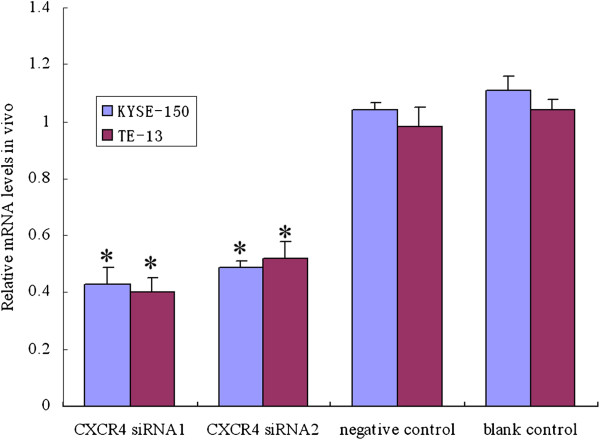
CXCR4 siRNA inhibited xenografts tumor tissue CXCR4 mRNA expression effectively in vivo. In nude mice esophageal carcinoma cell xenografts model, xenografts tumor tissue CXCR4 mRNA expression was quantified by real time PCR. CXCR4 siRNA inhibited xenografts tumor tissue CXCR4 mRNA expression in vivo (*p <0.05).